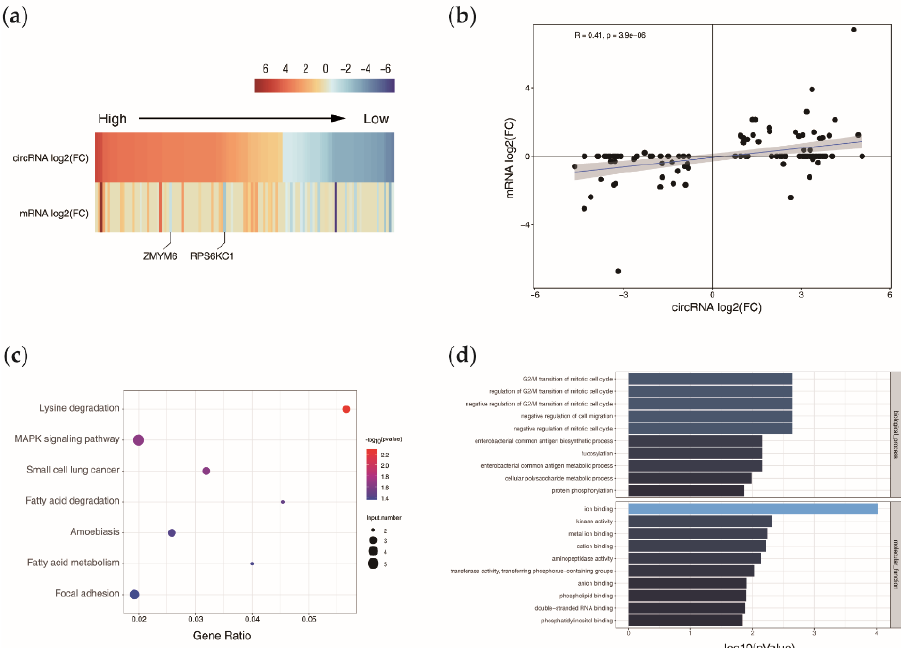
Figure 4. Relationship of circRNAs expression with their host genes and functional enrichment. ( a ) Heatmaps showing the relative abundances of circRNAs and corresponding mRNAs; ( b ) Pearson’s correlation analysis of the relative level of circRNAs and their host genes; ( c , d ) KEGG pathways and gene ontology (GO) items enriched by host genes.